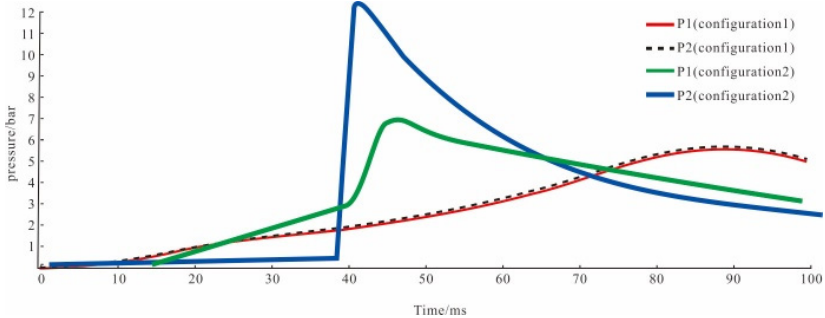
Figure 7. Pressure-time profile for sample 1 of configuration 1 and configuration 2.